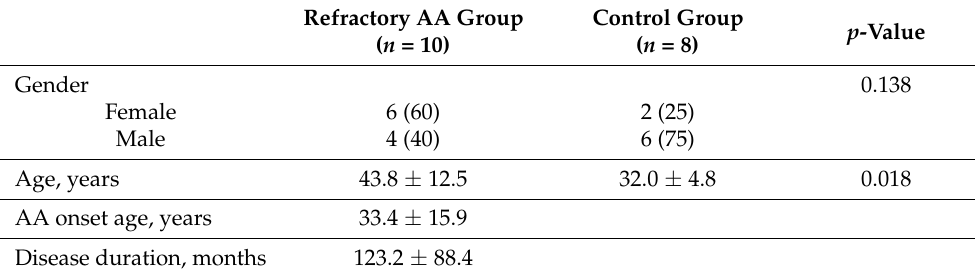
Table 1. Demographics and characteristics of patients included in the study.